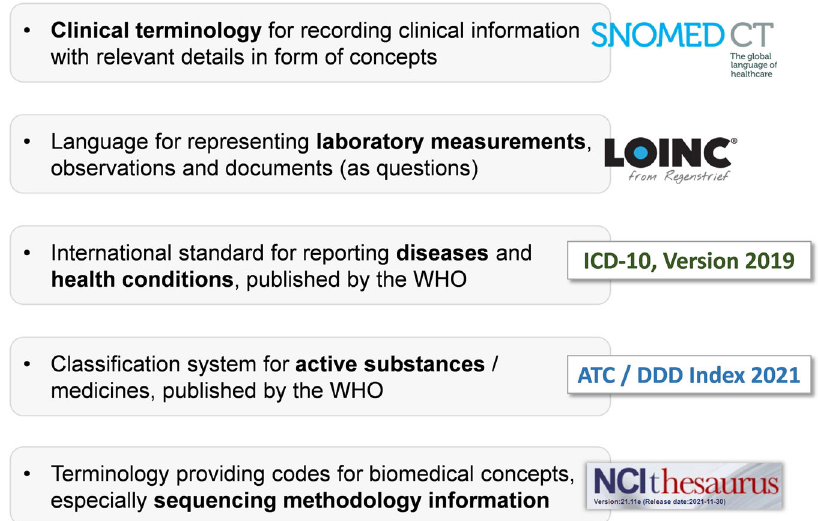
Fig. 6 Standard Terminologies. Overview of the main terminologies used to code ORCHESTRA variables to ensure semantic interoperability.